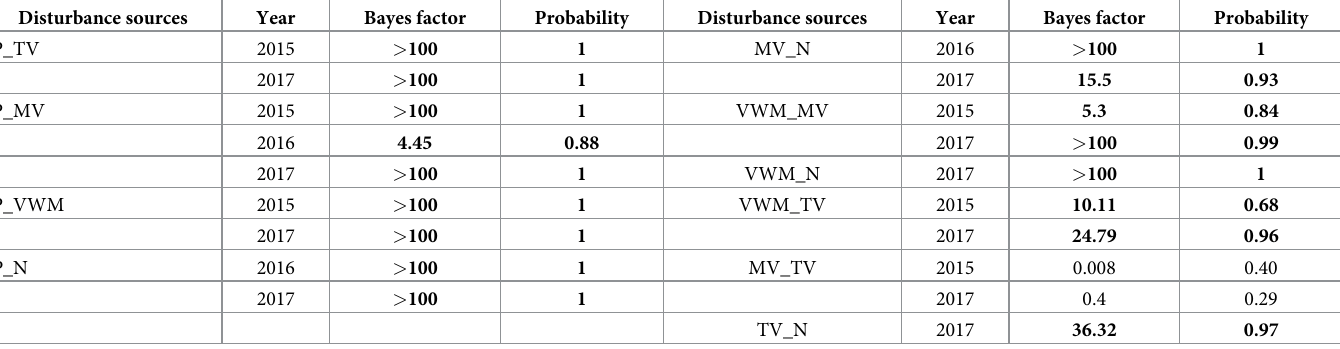
Table 2. Bayes factor comparison between pairs of disturbance sources based on the posterior proportion of disturbed seals presenting a high intensity reaction, i . e . flushing. Numbers in bold indicate credible differences. The probability that the first disturbance source was higher than the second one is also shown. Disturbance sources